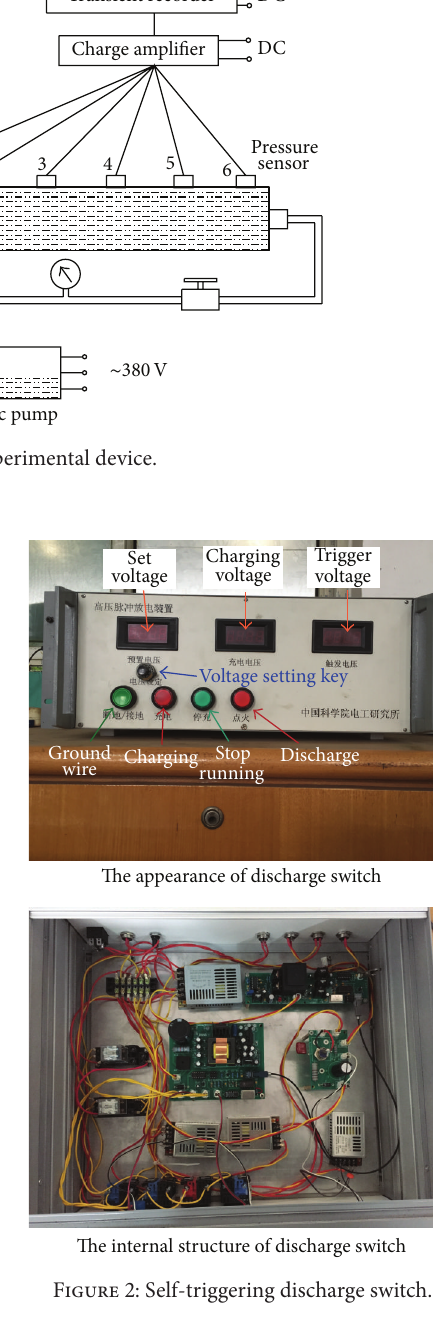
Figure 2: Self-triggering discharge